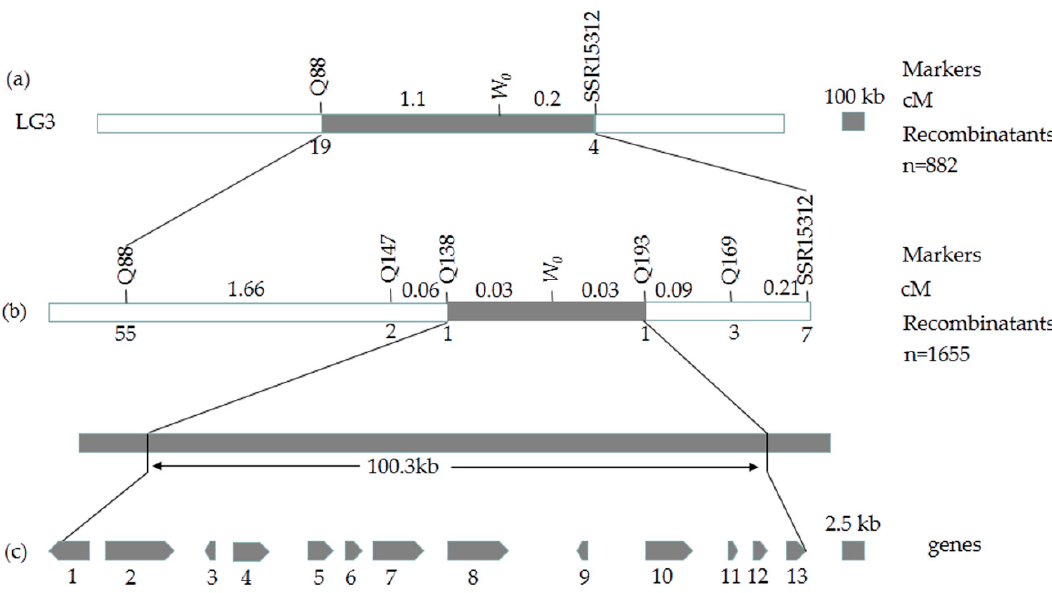
Figure 4. Sketch map of the fruit skin color gene and candidate gene analysis: ( a ) Linkage map constructed using 882 F 2 recessive individuals. The w 0 gene was mapped to the region between markers Q88 and SSR15312; ( b ) Fine mapping of the w 0 gene locus. The w 0 gene was localized to the region between the flanking makers Q138 and Q193 using 1655 recessive individuals; ( c ) The annotated gene in the candidate region of the w 0 gene locus.